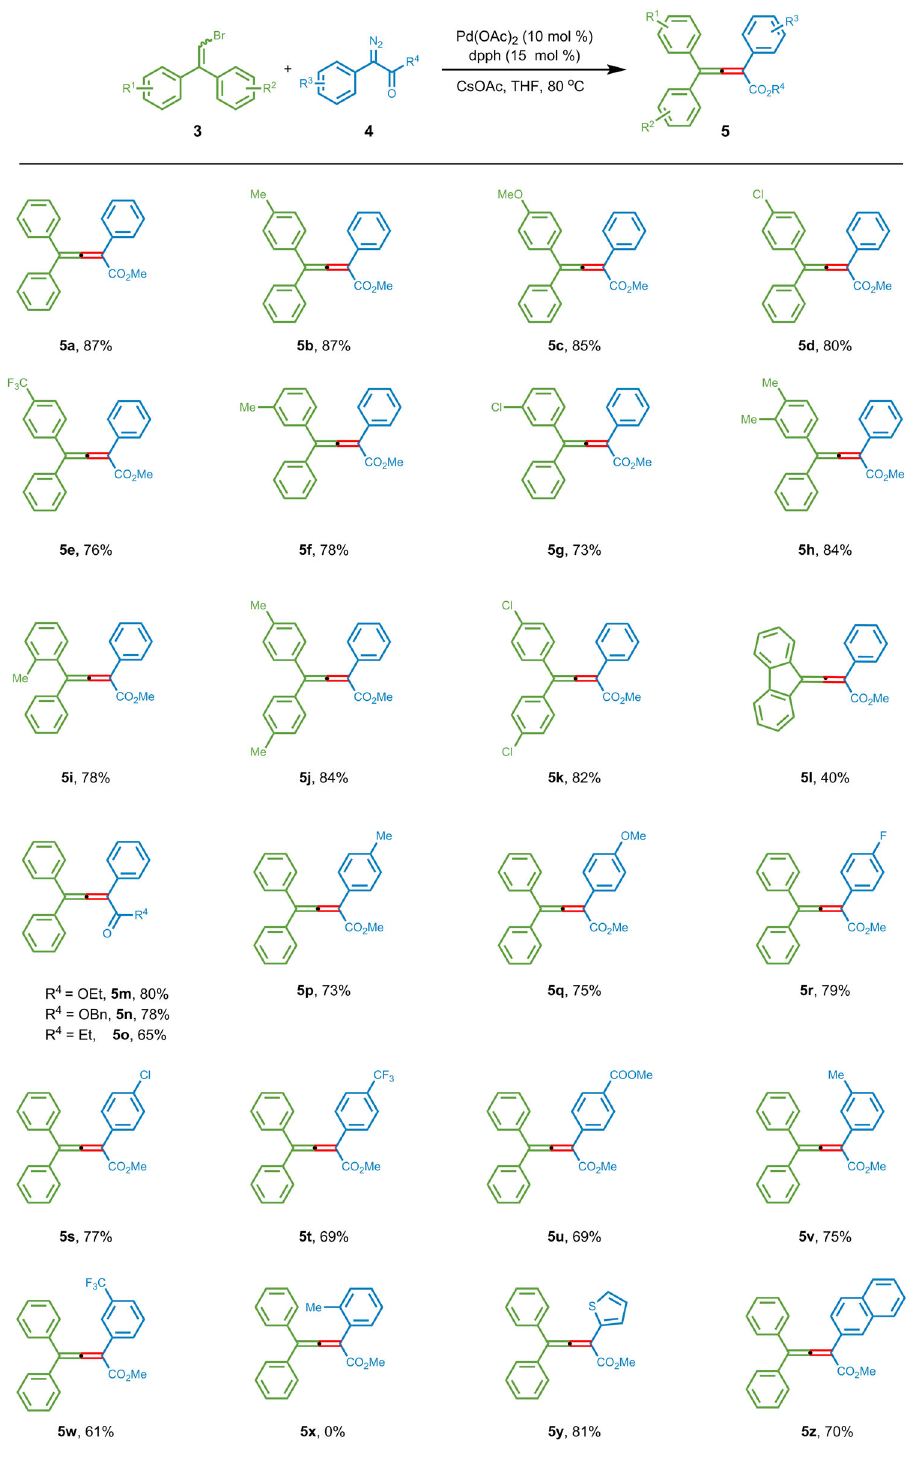
Fig. 3 Cross-coupling of 2,2-diarylvinyl bromides with diazo carbonyl compounds. a Reactions conditions: 3 (0.20 mmol), 4 (0.30 mmol, 1.5 equiv), Pd (OAc) 2 (0.02 mmol, 0.1 equiv), dpph (0.03 mmol, 0.15 equiv), CsOAc (0.30 mmol, 1.5 equiv), THF (2 mL), 80 o C. Isolated